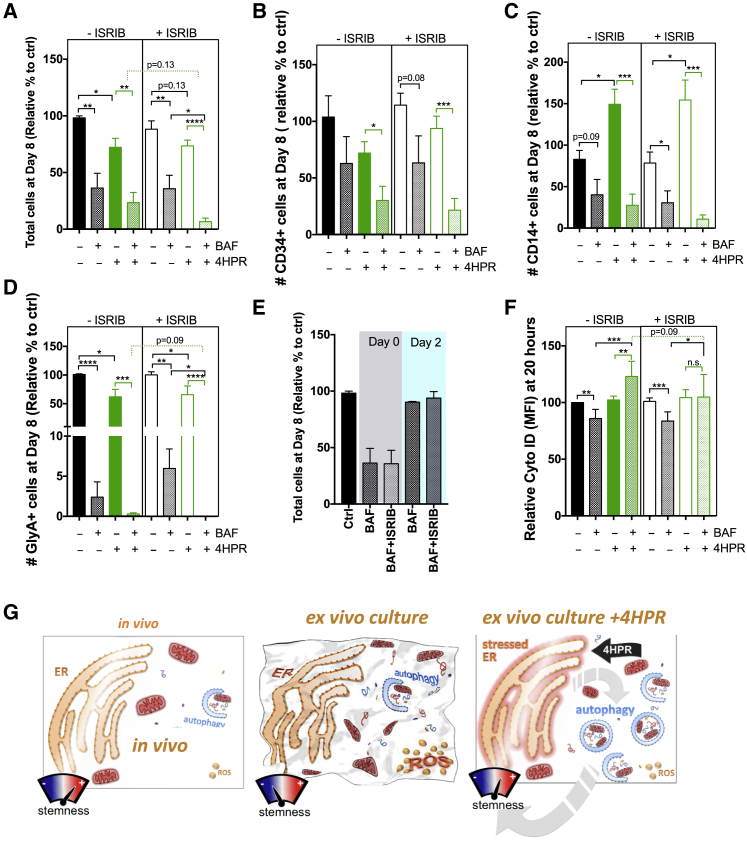
Sphingolipid Modulation by 4HPR Activates a Coordinated Proteostatic Pro-survival Response(A–D) Flow cytometry analysis at day 8 culture following autophagy inhibition with BAF and/or ISR inhibition with ISRIB in lin− CB (n = 3, in duplicate) beginning at day 0 for control or 4HPR-treated cells for number of (A) live cells, (B) CD34+ cells, (C) CD14+ cells, and (D) GlyA+ cells; represented as relative % to control; mean ± SEM.(E) Total number of cells at day 8 after BAF was added either starting at day 0 or day 2.(F) Autophagic flux at 20 h with indicated drugs was assayed with Cyto-ID MFI relative to control (2 CB, in triplicate).(G) Model for how 4HPR maintains stemness during ex vivo culture.∗p < 0.05; ∗∗p < 0.01; ∗∗∗p < 0.001.